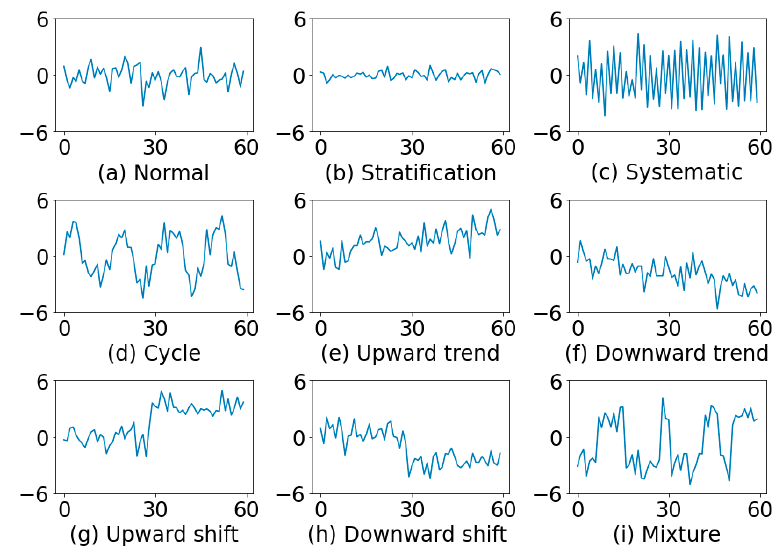
Figure 1. Typical examples of control chart patterns.